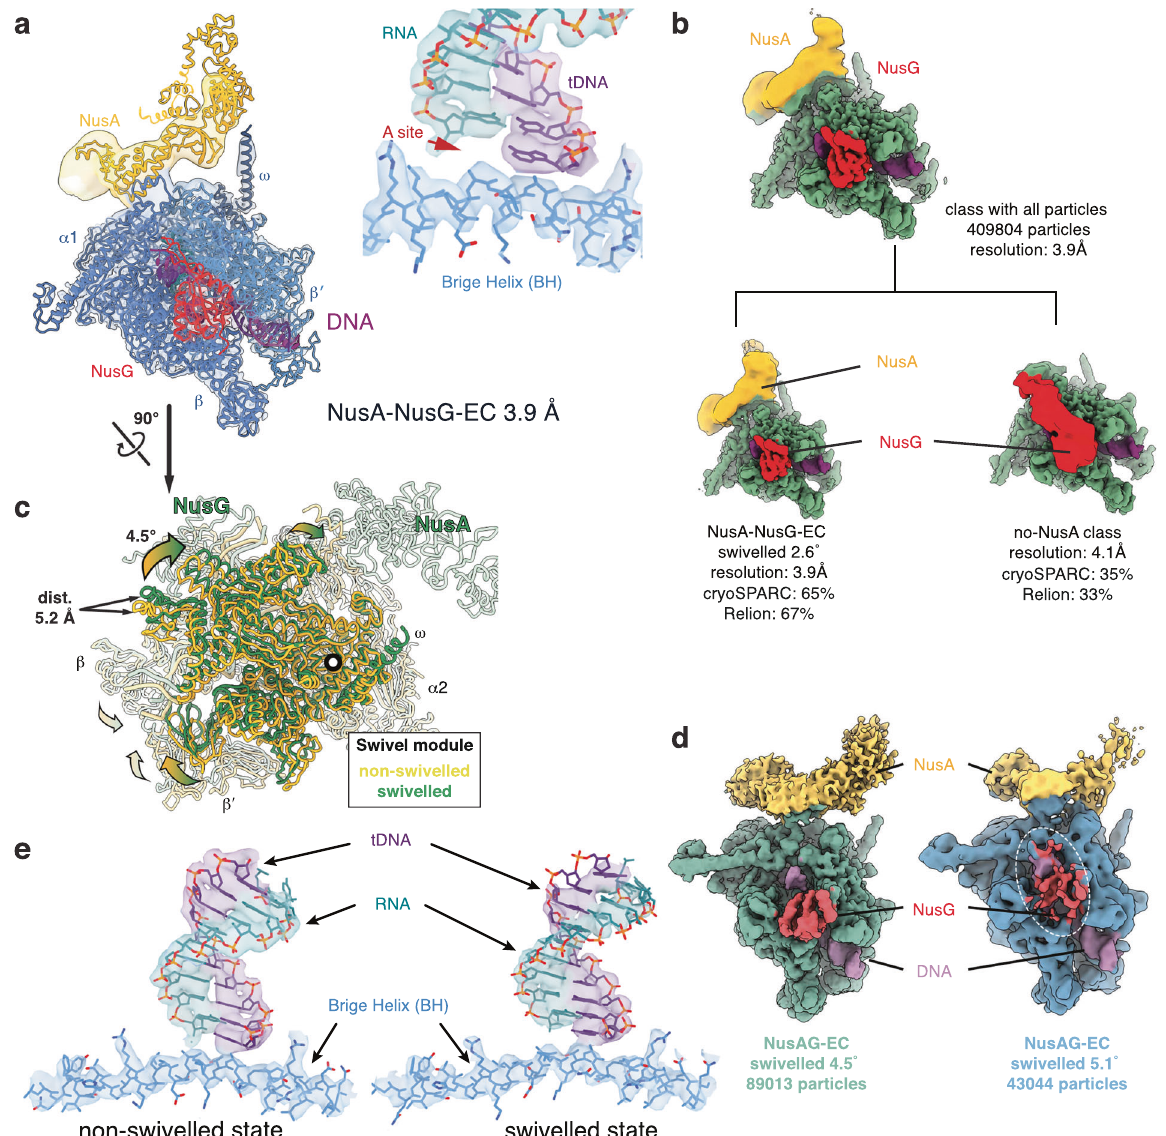
Fig. 3 Structures of the NusA-NusG-EC. a The NusA-NusG-EC reconstruction re fi ned to an overall resolution of 3.9 Å. The re fi ned atomic model shows a post-translocated active site (inset). NusA is shown in yellow, NusG in red. b 3D-classi fi cation of all particles resulted in 2 classes: one contains both factors (NusA-NusG-EC), the other lacks NusA. The NusA-NusG-EC class re fi ned to 3.9 Å (shown in panel a). However, the NusG-KOW EM density is not resolved. The class lacking NusA re fi ned to 4.1 Å. Low-pass fi ltering the NusG density to 10 Å resolution (red, bottom right), reveals the contact between NusG-KOW and FTH. c The swivel module can rotate up to 4.5° and sample a range of orientations intermediate to NusG-EC and NusA-EC. Displacements furthest away from the rotation axis are up to 5.2 Å. d NusG and NusA bind to RNAP at swivel angles up to at least 4.5°, but EM density for NusG was weaker at more extreme swivel angles (~5° - seen in 3D variability analysis), while that for NusA (yellow) was not. e EM density for the RNA-DNA hybrid (indicated by short arrows) was better de fi ned in non-swivelled states, suggesting a more constrained RNA substrate. Here, swivelled NusA-EC, and non- swivelled NusA-NusG-EC classes, which re fi ned to the same resolution are compared at the same contour to levels seen in absence of any TFs (Fig. 4b). Thus, similar to a have opposing effects on the ops -pause.